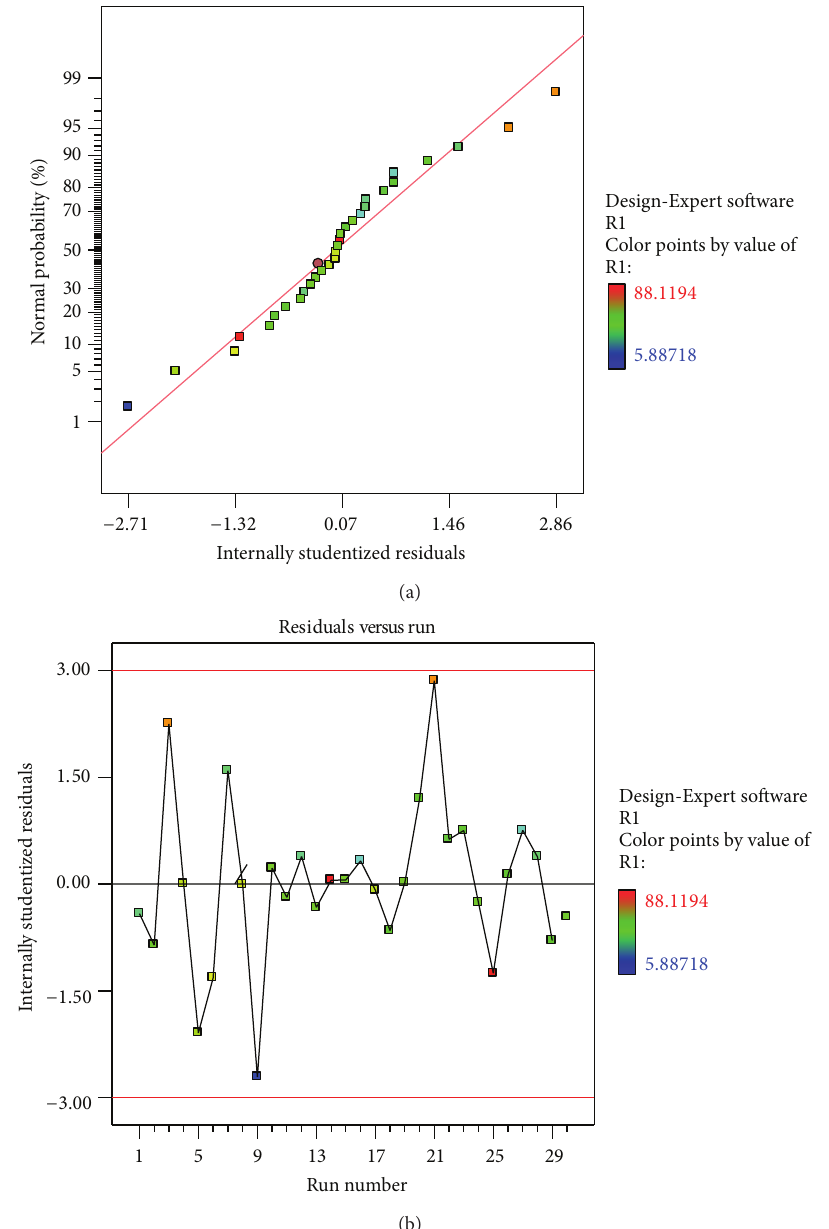
Figure 2: Residual plots for removal of AR17 in the presence of various concentrations of inorganic